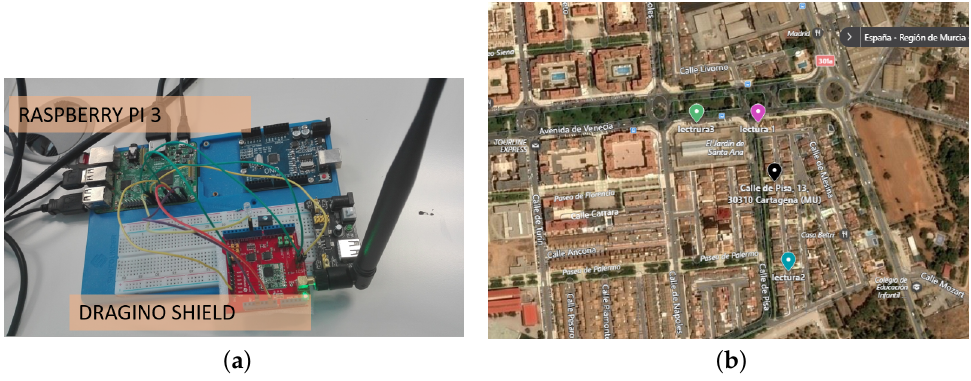
Figure 4. Single-channel gateway. ( a ) Gateway assembly. ( b ) Gateway coverage